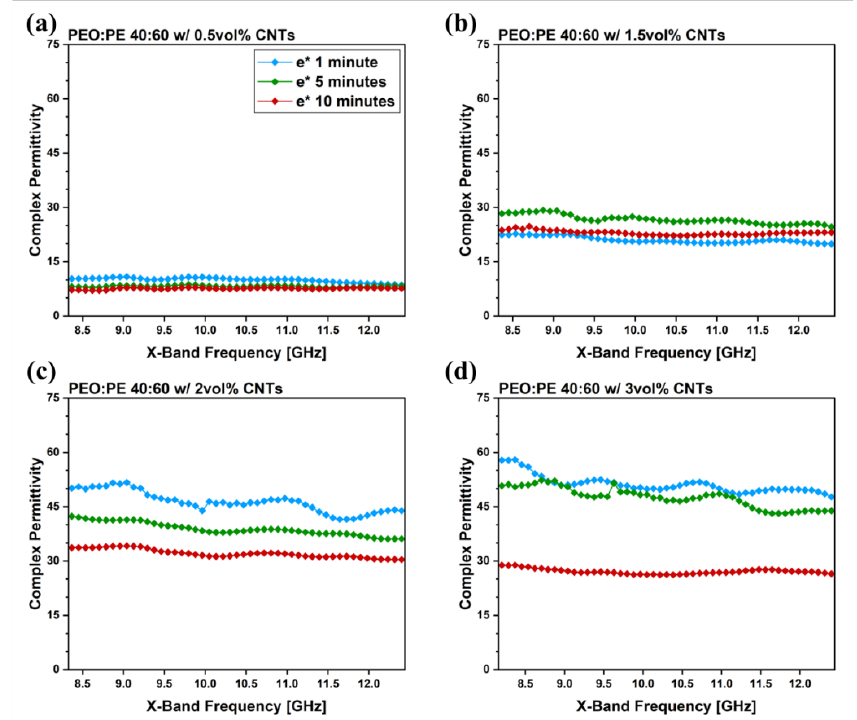
Figure 5. Complex permittivity data within the X-band for PEO/PE 40:60 blends containing MWCNTs at concentrations of ( a ) 0.5 vol%, ( b ) 1.5 vol%, ( c ) 2 vol%, and ( d ) 3 vol%.